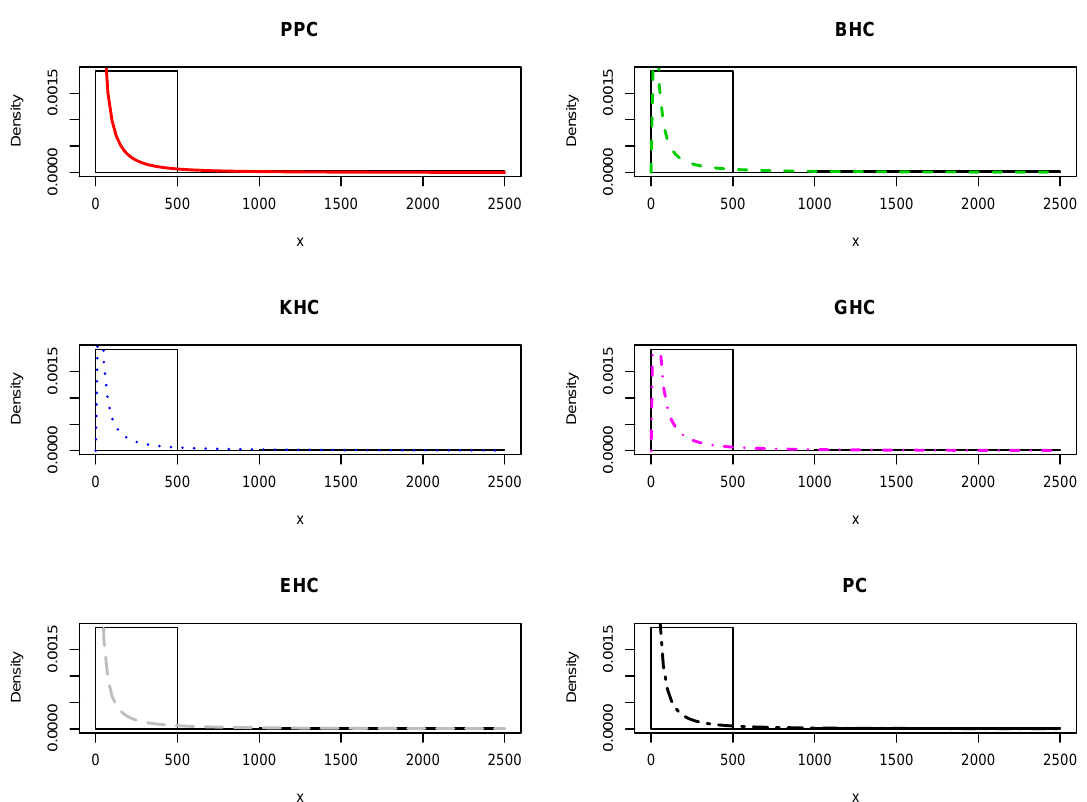
Figure 3 - Density plots of the LONPC, BHC, KHC, GHC, EHC and PC models for Failure data.